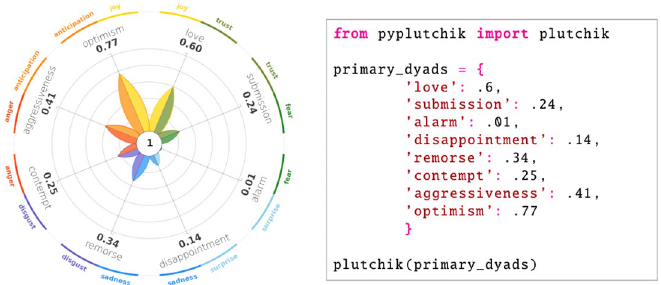
Fig 8. Primary dyads’ wheel generated by code on the right. Each entry in the Python dict is a numeric value 2 [0, 1].